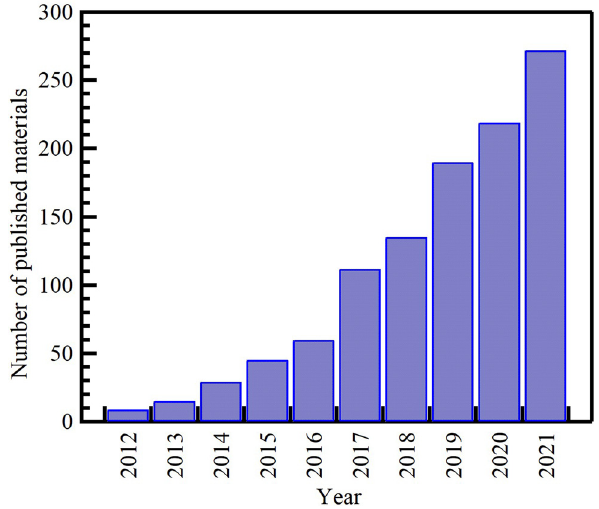
Figure 29: Publication distribution of papers on waste recycling into